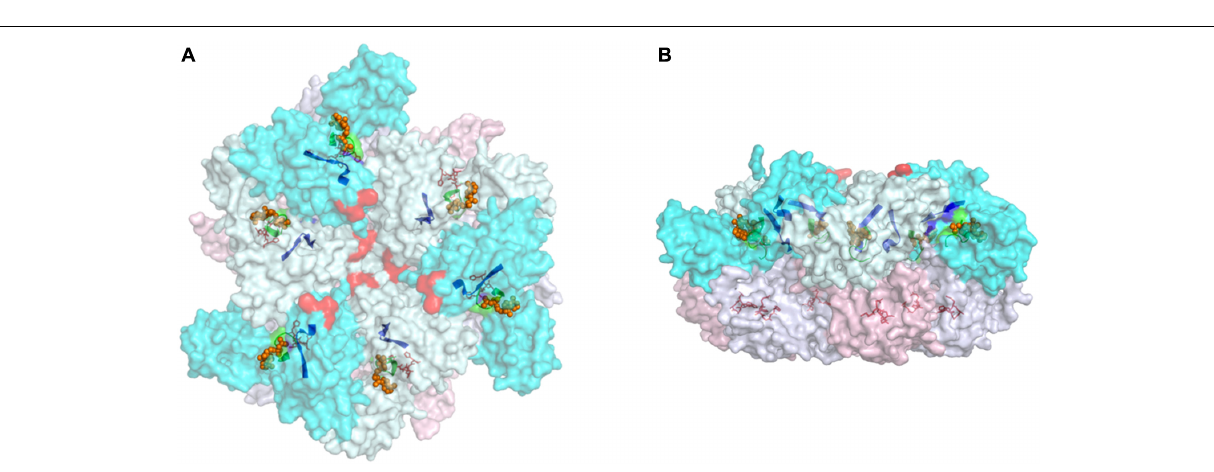
FIGURE 2 | Top (A) and side (B) views of the cytoplasmic region of hexameric FtsH complex from T. thermophilus (PDB:2DHR). Annotations: protomers are defined according to the status of its ATPase domains (“open” confirmation in cyan and “closed” confirmation in pale-cyan). The protease domains of “open” protomers are labeled pink, and the “closed” counterparts are in blue-white. Selected motifs presented in a non-translucent color include Walker A (green ribbon) and B (blue ribbon), and the zinc coordinates of the protease site (red sticks). The proposed FVG motif responsible for substrate binding is displayed as a red sphere, and ADP molecules are shown as orange